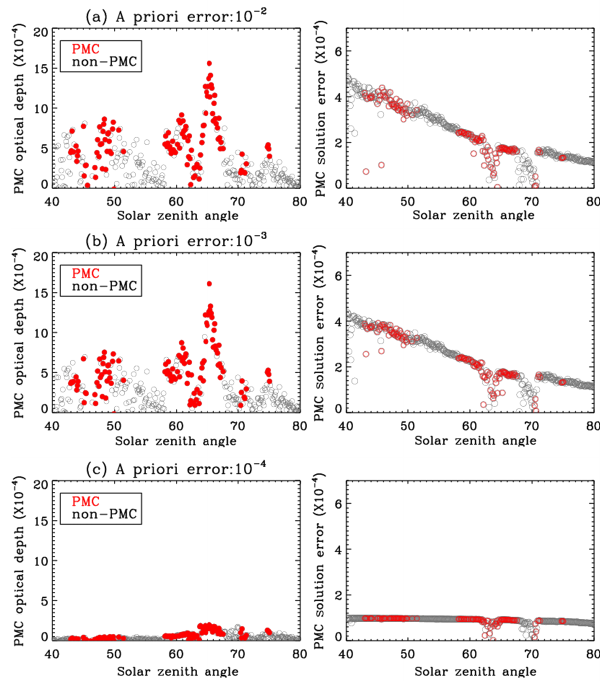
Figure 8. Retrieved PMC optical depth values and retrieval errors as functions of solar zenith angle for OMI orbit number 15881 and cross-track position 13 (UV1) on 10 July 2007 with a fixed a priori value of 0 and three a priori error values: (a) 10 − 2 , (b) 10 − 3 and (c) 10 − 4